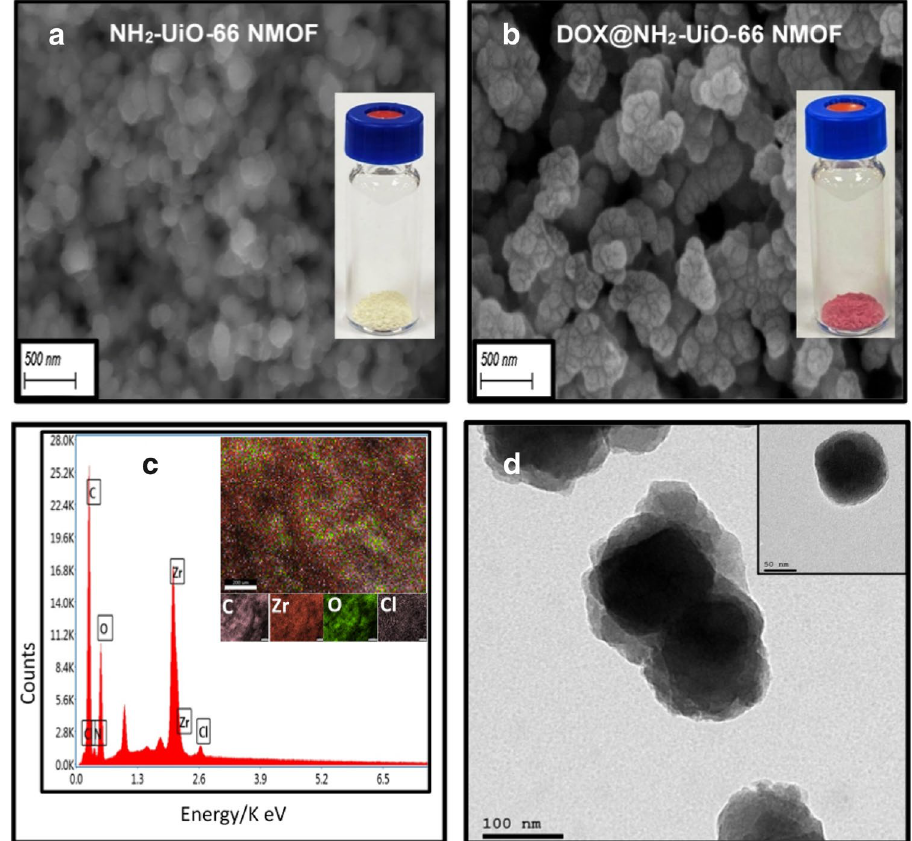
Figure 4. ( a ) SEM for plain NMOF ( b ) DOX-loaded NMOF and at upper right two images showing the physical appearance for both of NMOF and DOX-loaded NMOF, respectively, ( c ) Elemental mapping of DOX- loaded NMOF, ( d ) TEM of DOX-loaded NMOF, with a focus on single MOF crystal (inset).